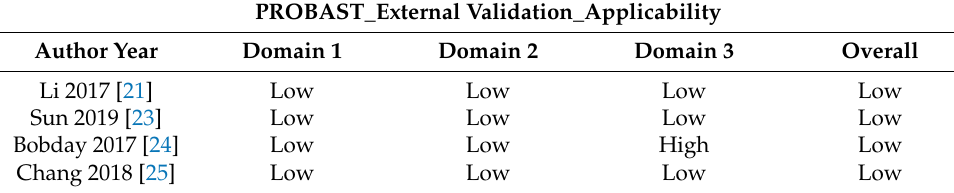
Table 5. Applicability of models’ external